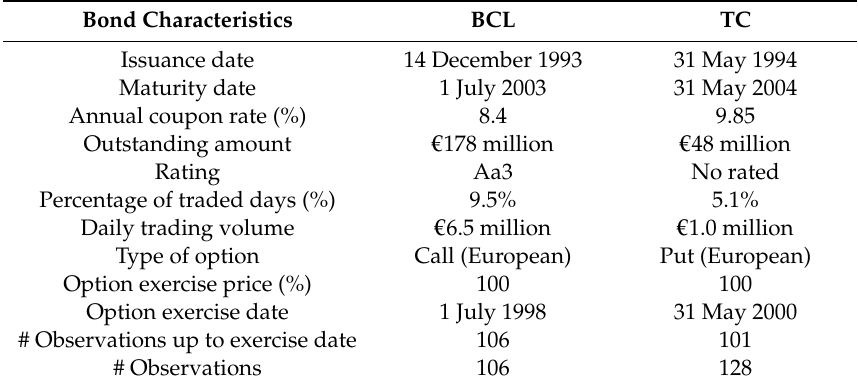
Table 1. Main features of the issues, i.e., Banco de Cr é dito Local (BCL) and T ú nel del Cad í